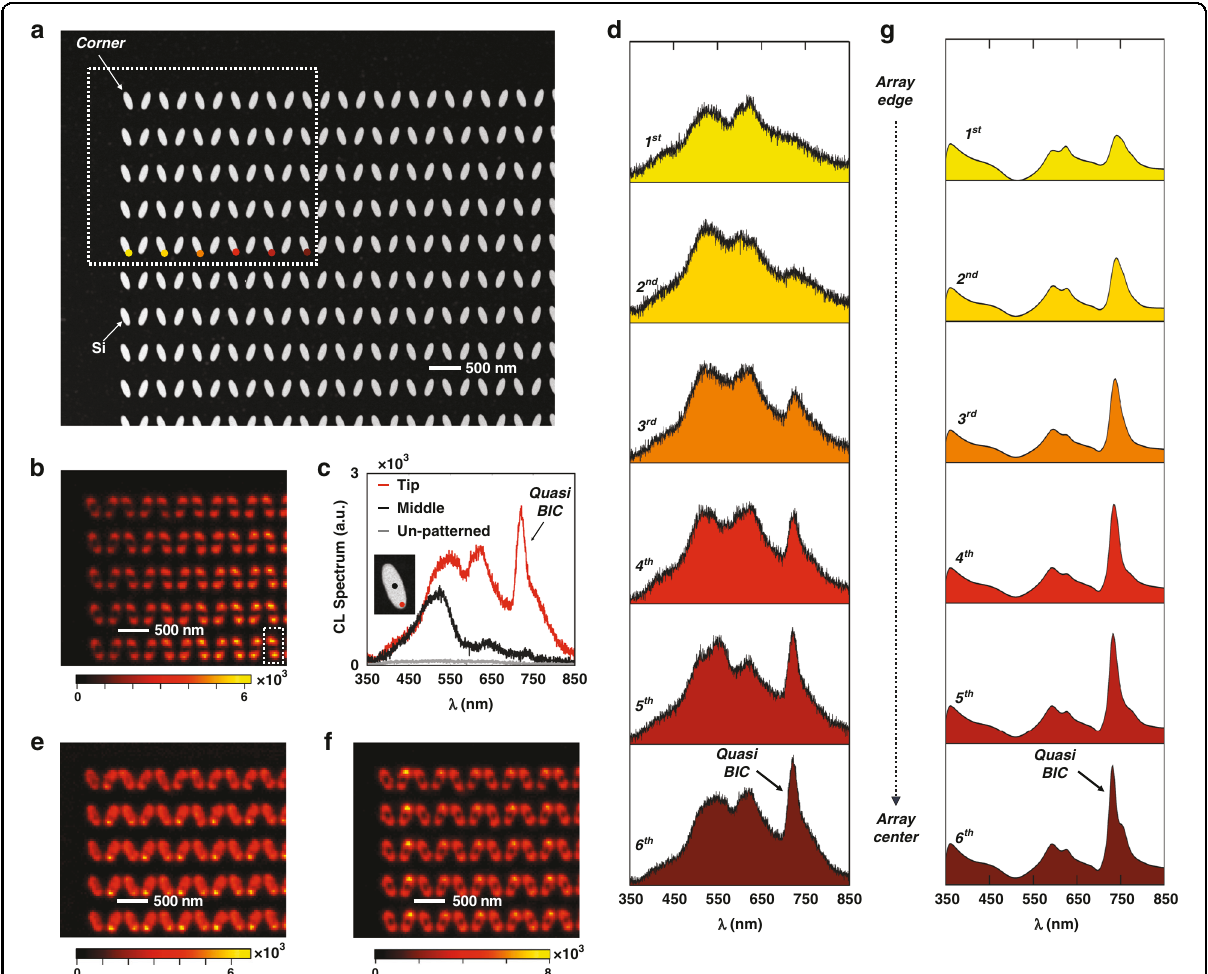
Fig. 4 Characterizing the coherent interaction length of the quasi-BIC resonance in a Si nanoantenna array with a tilt angle θ of 70°. a STEM HAADF image, showing the corner of a fabricated Si nanoantenna array with 130 × 130 elements. The white dotted rectangle highlights the area used for the CL mapping experiment and the colored dots denote the measurement positions for investigating the CL spectrum evolution. b CL intensity map at 722 nm, the quasi-BIC resonance wavelength; note the lower emission closer to the array edge. The wavelength bandwidth for the CL integration is 17 nm. c CL spectra from the “ tip ” position and “ middle ” position of one selected antenna as highlighted by the white dashed line in ( b ). The 722 nm emission at the “ tip ” position is strongly enhanced due to the quasi-BIC resonance. The CL spectrum as measured from un-patterned 90-nm-thick Si fi lm is plotted in gray for benchmarking. d Evolution of the measured CL emission spectra when going from the array edge towards the array center. It shows that the quasi-BIC resonance requires the presence of neighboring array antennas. e , f CL maps at the Mie resonance wavelengths of the individual antennas (e ) 522 nm and ( f ) 614 nm; note the uniform emission all the way to the array edge. g Simulations of the CL spectrum